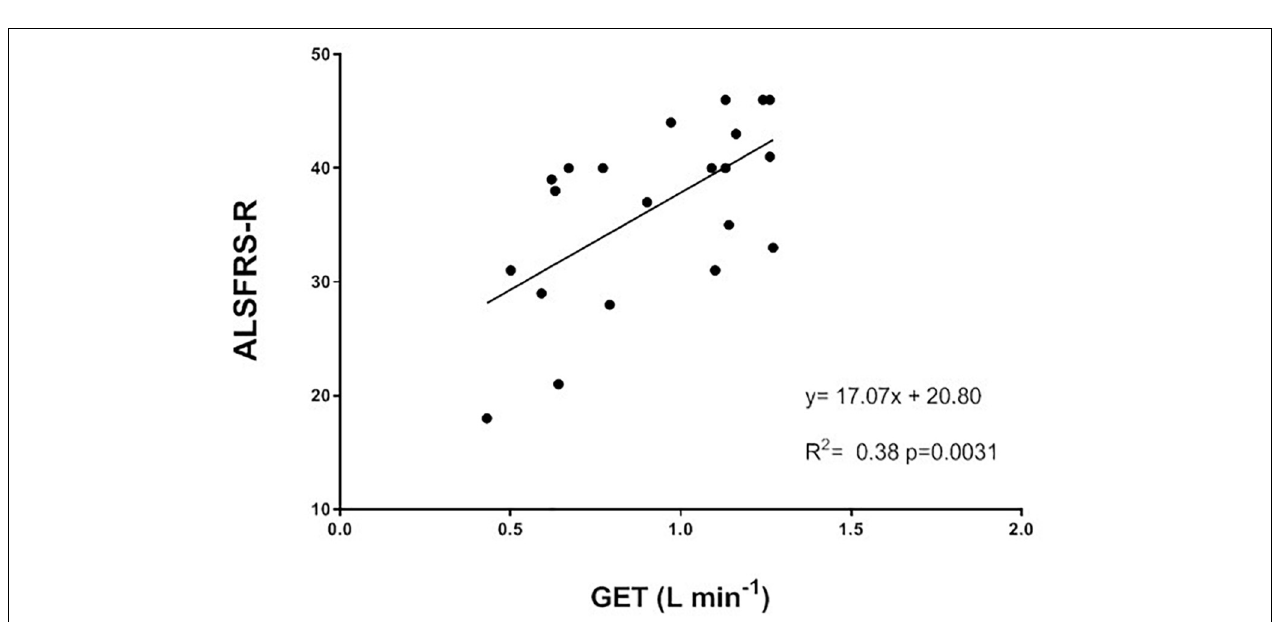
FIGURE 6 | Changes in percentage for the ALSFRS-R subscores (bulbar, respiratory and total motor function) for the training (TRAIN) and usual care (UC) groups. Average data are expressed as mean + SE. ∗ p < 0.05 between T0 and T1 in the UC group.